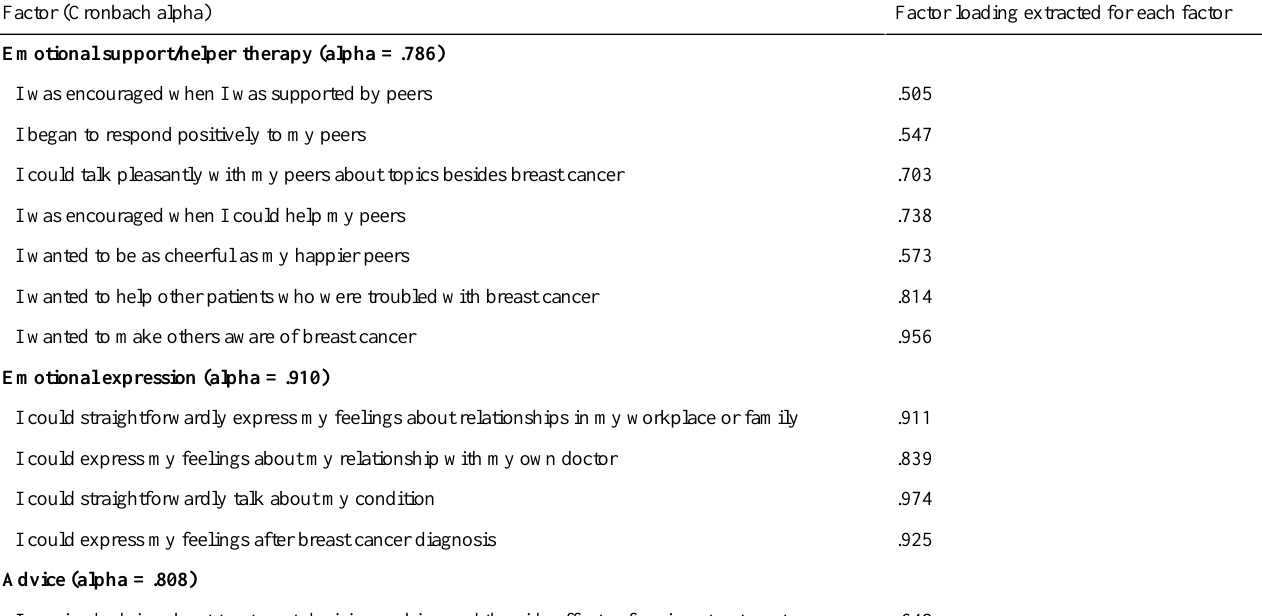
Table 4. Factor analysis of peer support functions for lurkers (n = 113) Emotional support/helper therapy (alpha =